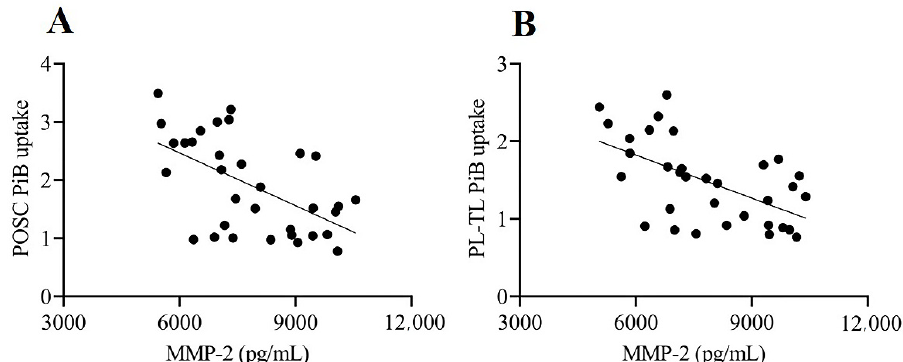
Figure 5. Relationship between CSF levels of MMP-2 and PiB uptake in the brain ROI. CSF levels of MMP-2 are negatively correlated with PiB uptake in the ( A ) posterior cingulate gyrus ( β = − 0.399; 95% CI, − 0.782 to − 0.017, p = 0.041) and ( B ) parietotemporal lobe ( β = − 0.476; 95% CI, − 0.856 to − 0.096, p = 0.016). PL-TL—parietotemporal lobe; POSC—posterior cingulate